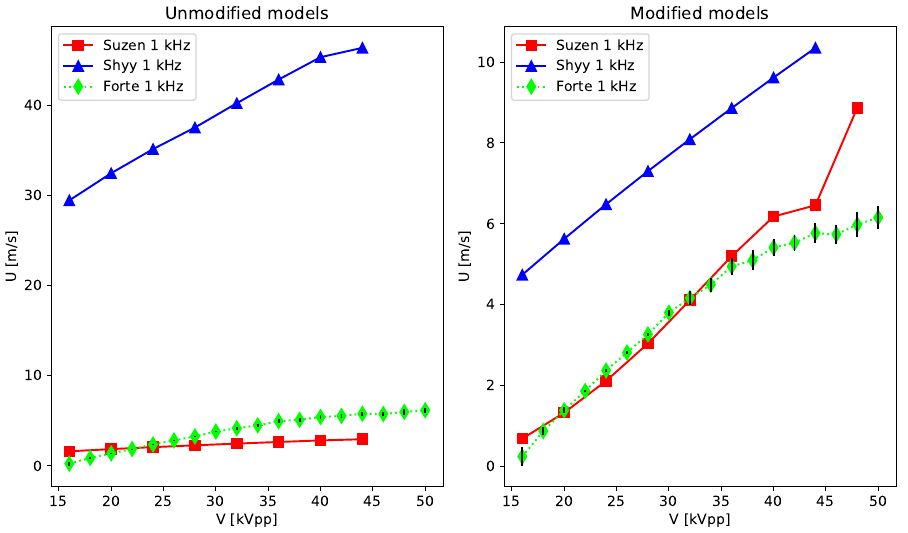
Figure 13. Maximum induced velocity as a function of the voltage at 1 kHz (case 3